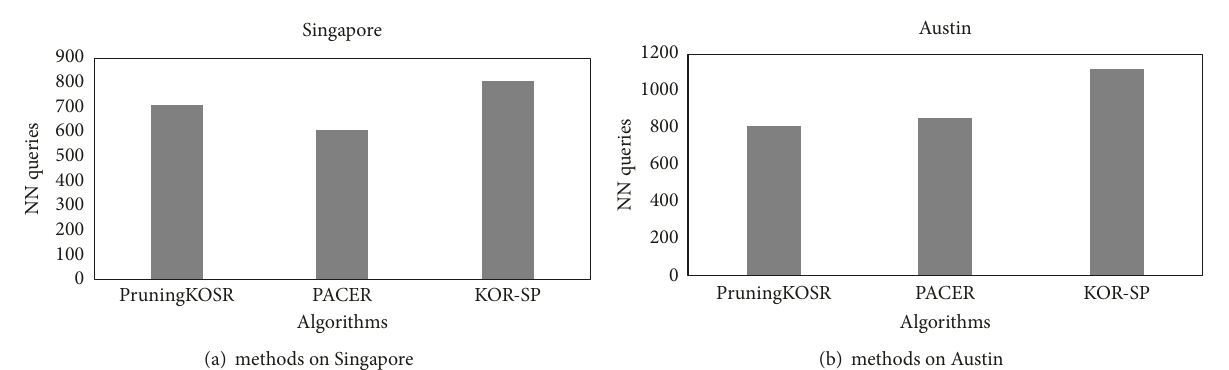
Figure 4: Examined routes.